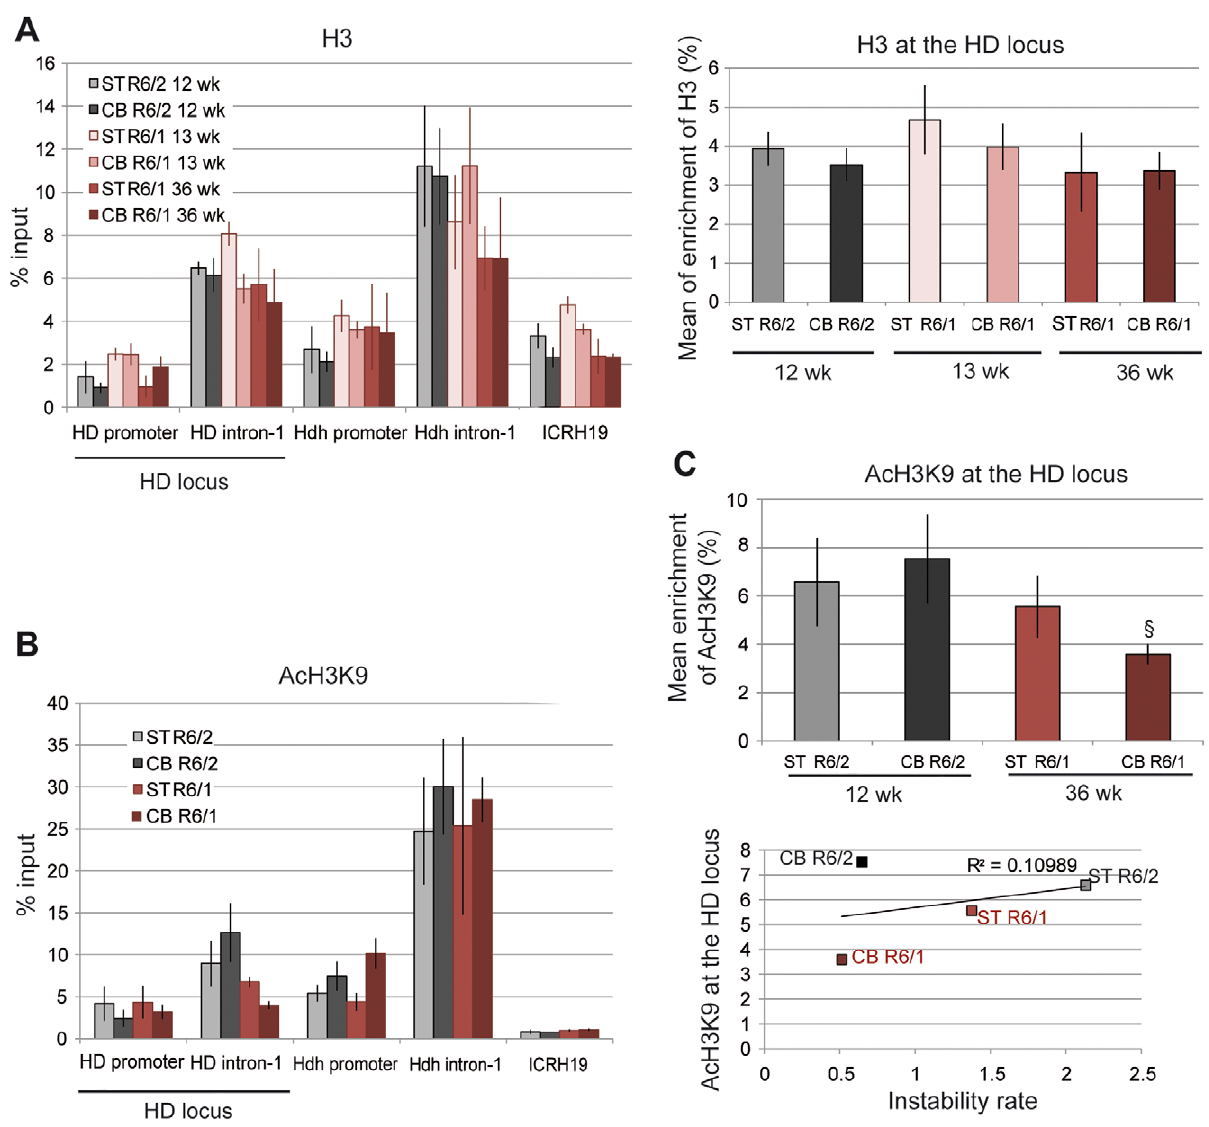
Figure 3. H3 and AcH3K9 at the HD locus in R6/1 and R6/2 striatum and cerebellum. A. Left panel. ChIP analyses from the striatum and the cerebellum of R6/1 and R6/2 mice using antibodies to H3. R6/1 mice at early and late-pathological stages (13- and 36-wk), and R6/2 mice at late pathological stage (12-wk) were used. Right panel. Global analysis of the level of H3 at the HD locus, assessed as in Figure 2. Error bars, sem. B. ChIP analyses from the striatum and the cerebellum of R6/1 mice at late-pathological stage (36-wk) and R6/2 mice at late-pathological stage (12-wk), using antibody to AcH3K9. C. Upper panel. Global analysis of the level of AcH3K9 at the HD locus, assessed as in Figure 2. Error bars, sem; 1 , p , 0.05. Lower panel. Correlative analysis of CAG instability rates with mean levels of AcH3K9 at the HD locus. R6/1 mice of 36 weeks and R6/2 mice of 12 weeks were used for correlation analysis.